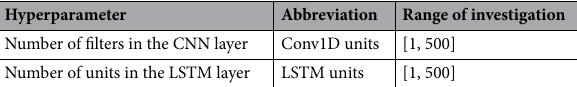
Table 1. Search space for the variables during GA optimization.